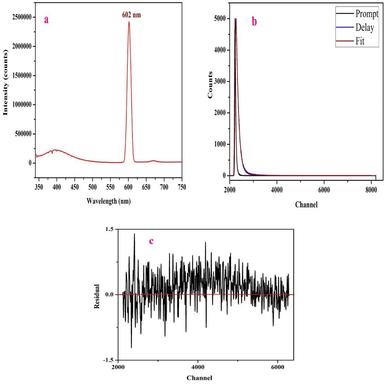
(a) Emission spectrum (b) Fluorescence lifetime spectrum (c) Residual fit of LHFFAM.